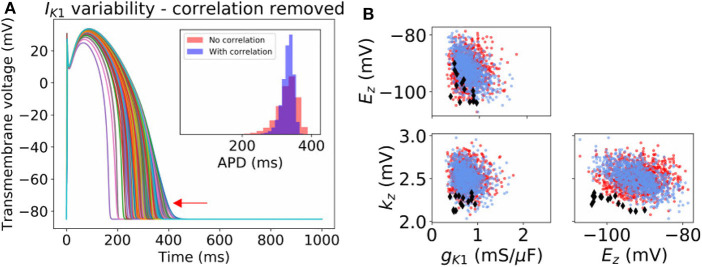
Effect of neglecting inferred correlations in IK1 parameters. (A) 1,000 sample action potentials with histograms of APD (N = 100, 000) in inset. Red arrow indicates some non-physiological behavior that arises upon neglecting the correlation between IK1 parameters. (B) Corresponding sampled parameters gK1, Ez, kz. Blue dots: sampling from original distribution which included parameter correlation. Red dots and black diamonds: samples from distribution where correlation was removed. Black diamonds: parameter values which led to non-physiological action potentials.